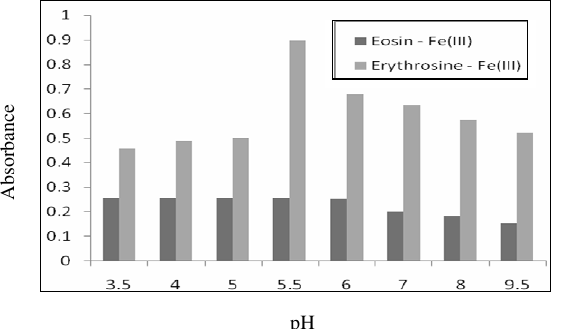
Figure 1. Absorbance spectra of (a) Eosin- Fe(III) complex (b) Erythrosine - Fe(III) complex, in 0.5% triton x-100 at pH 5.5